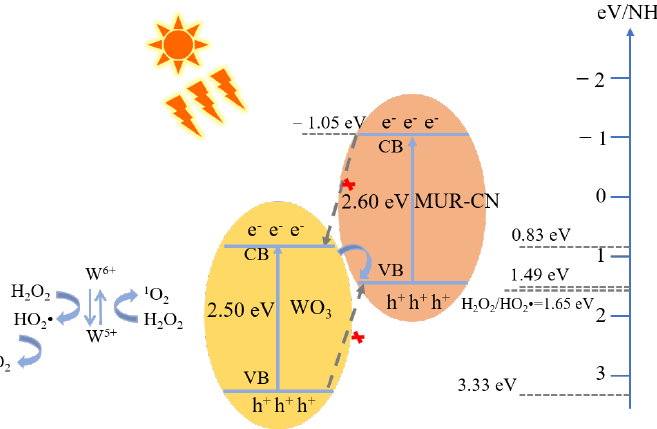
Figure 12. Schematic illustration of catalytic mechanism of MCA-CN/WO 3 in photo-Fenton-like pro-